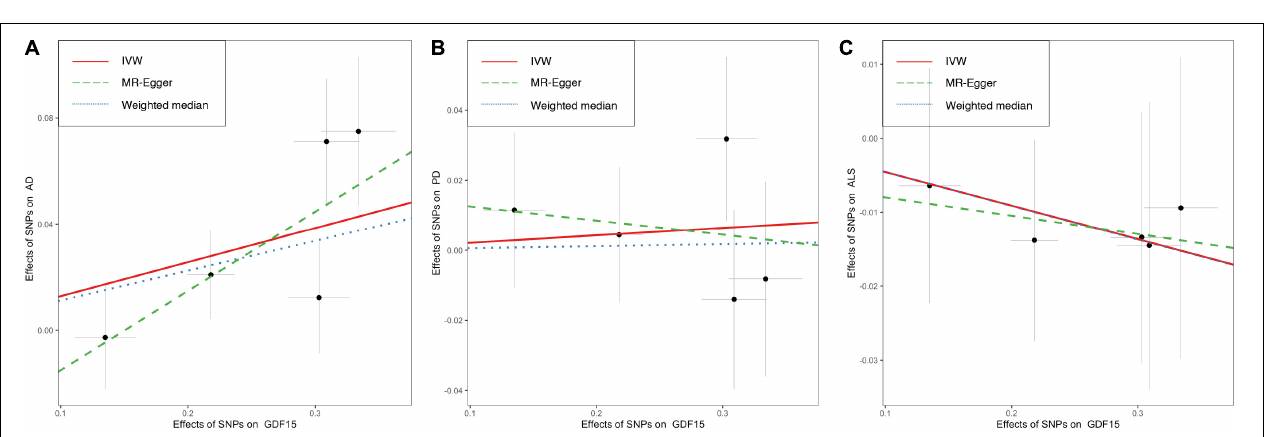
FIGURE 2 | Association of genetically predicted GDF-15 with three neurodegenerative diseases by Mendelian randomization approaches. Elevated levels of circulating GDF-15 were associated with a higher AD risk (OR = 1.14; 95% CI, 1.04–1.24; P = 0.004) per one SD increase in GDF-15, whereas there were no causal effects of GDF-15 on PD and ALS. AD, Alzheimer’s disease; ALS, amyotrophic lateral sclerosis; CI, confidence interval; GDF-15, growth differentiation factor 15; IVW, inverse-variance weighted model; OR, odds ratio; PD, Parkinson’s disease.